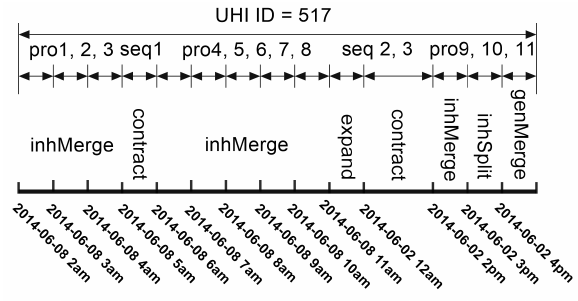
Figure 9: Database model